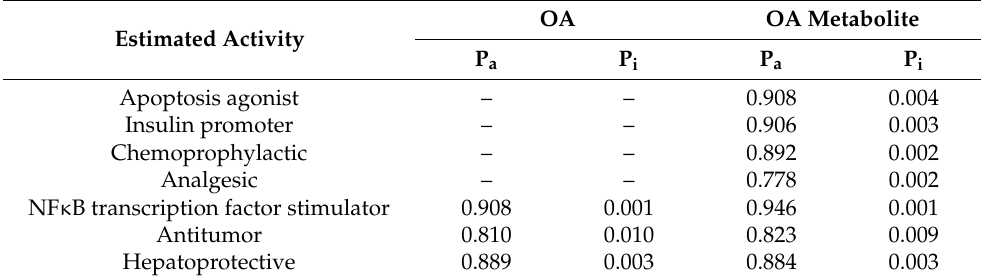
Table 3. Estimated biological activity of OA and its metabolite.